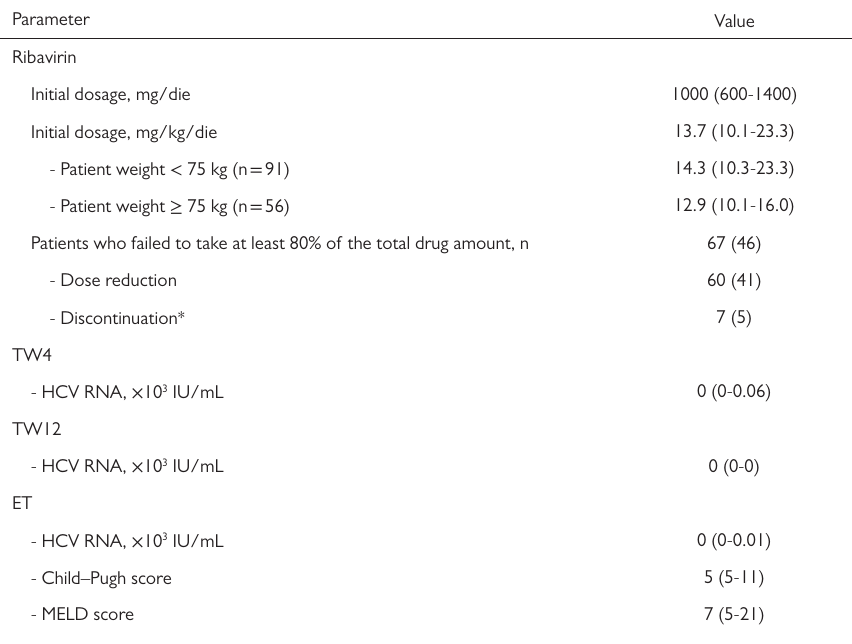
Table 2. Main Clinical and Virological Parameters of Patients During Antiviral Treatment, n = 147 Parameter